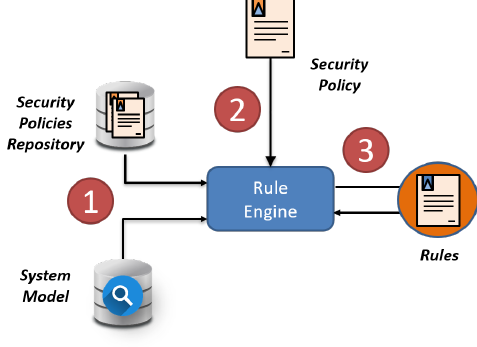
Figure 4. Rule engine